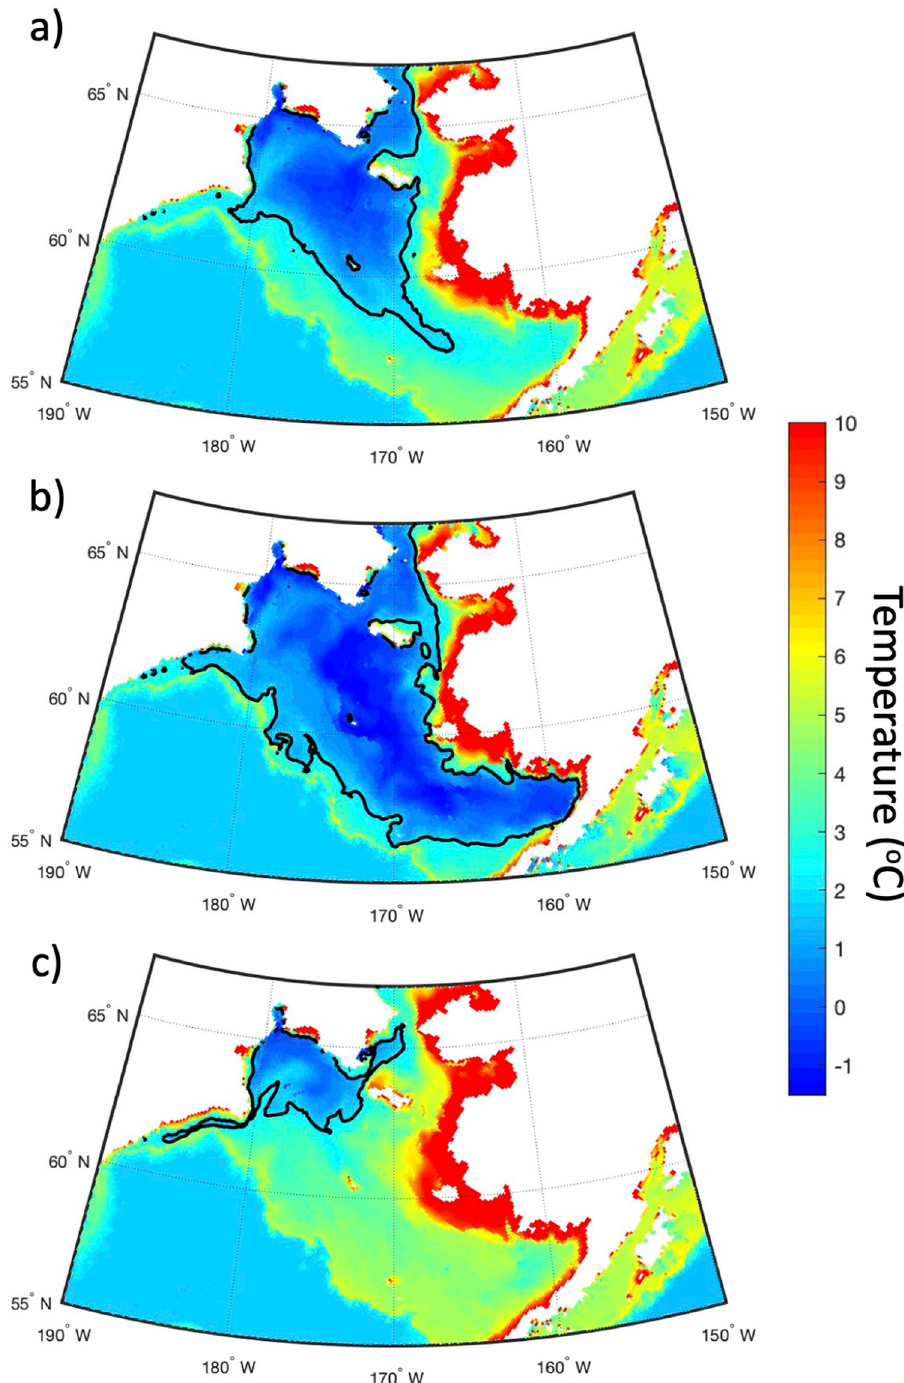
Fig 5. Bottom water temperature. Bottom water temperature (˚C) during July 1980–2018 mean (a), 2012 (b), and 2018 (c) as calculated by RASM. The black contour line indicates the position of the 2˚C isotherm on the Bering Sea shelf and is the boundary of the CP. Figure created using Matlab (v. 2018a) from the authors’ data.